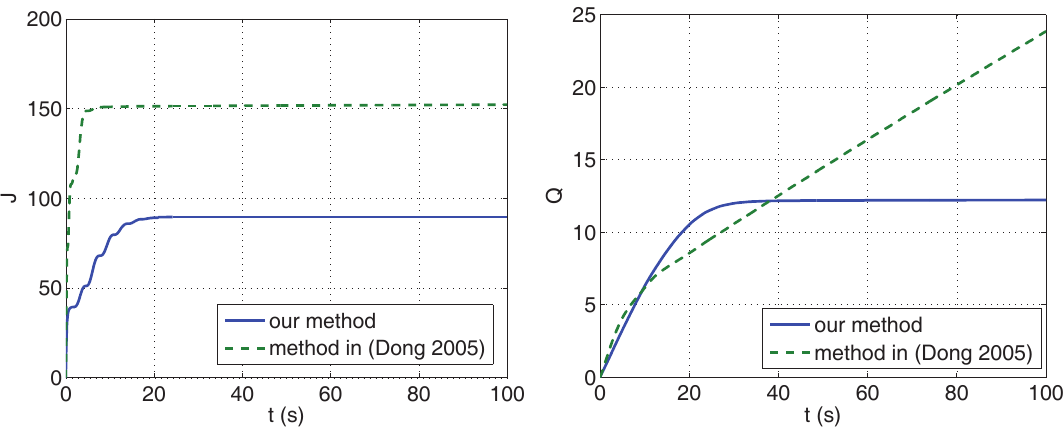
Figure 7. Comparison of energy consumption J and performance Q of this paper and